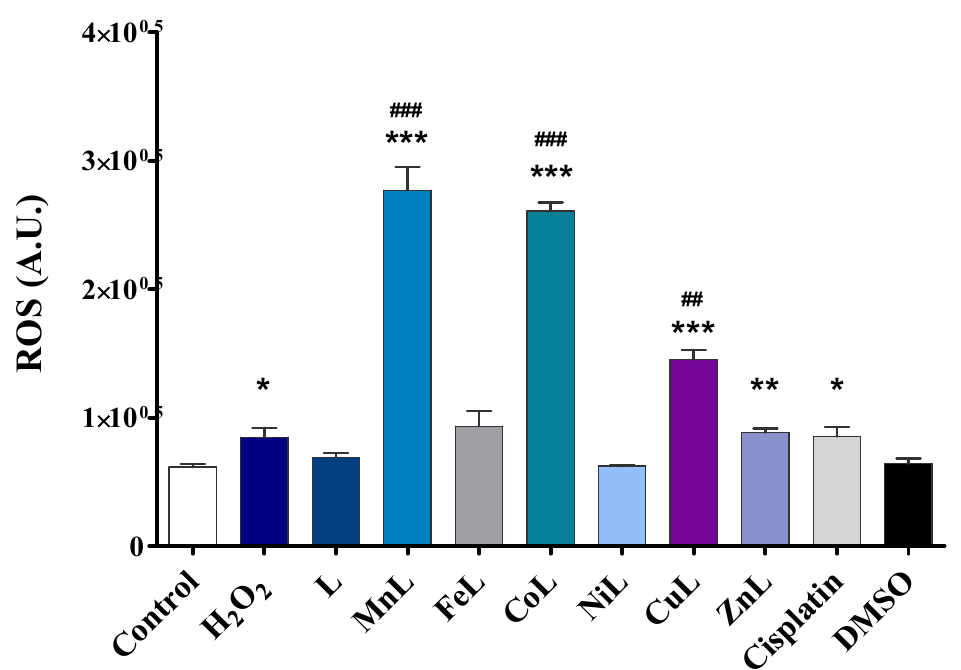
Figure 4. To measure ROS generation, the fluorescent probe H 2 DCF-DA was used. HepG 2 cells were treated for 24 h with 250 µ M H 2 O 2 , 50 µ M metal complexes, and associated ligands. The data are presented as mean ± SEM ( n = 3). * p < 0.05, ** p < 0.01, *** p < 0.001 relative to the control. ## p < 0.01, ### p < 0.001 relative to the H 2 O 2 .